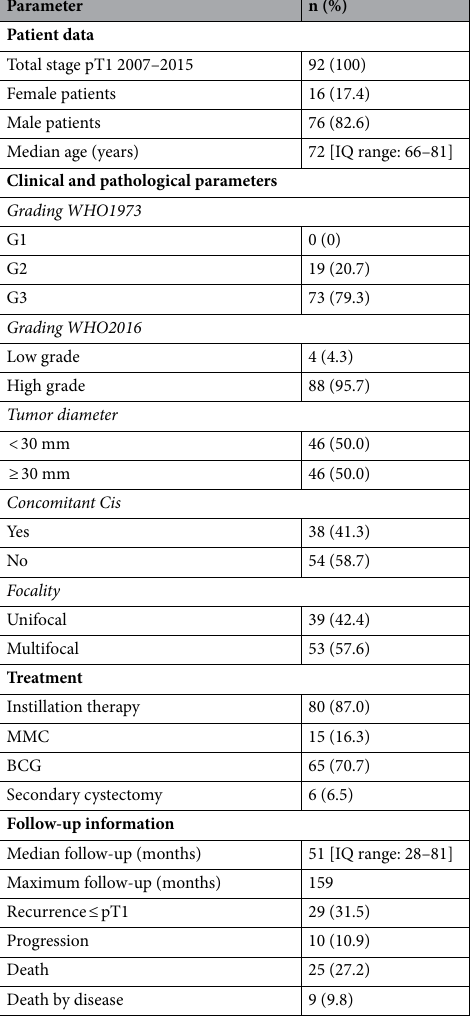
Median Bud count (%) Tumor invasion pattern (%) < 0.9 ≥ 0.9 Compact Discontinuous Cohesive Discohesive